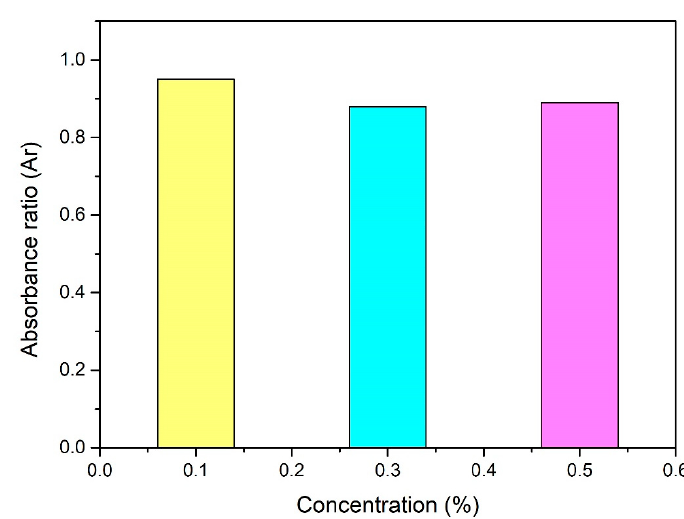
Figure 10. Absorbance ratio for all concentration.